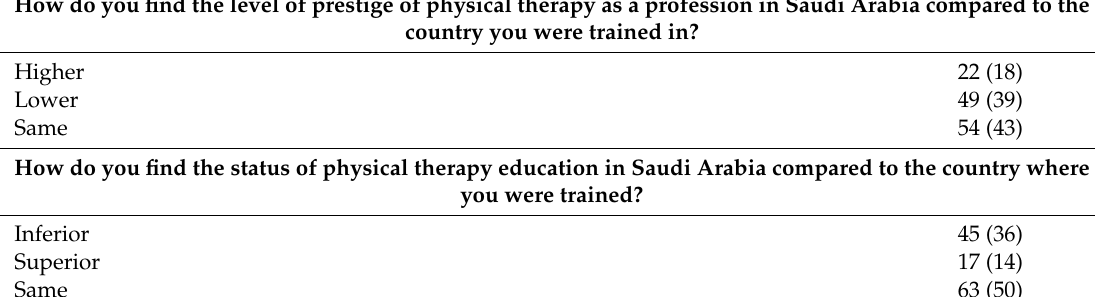
Table 4. Experience of respondents regarding physical therapy education, profession, and training in Saudi Arabia. Percentages are provided in